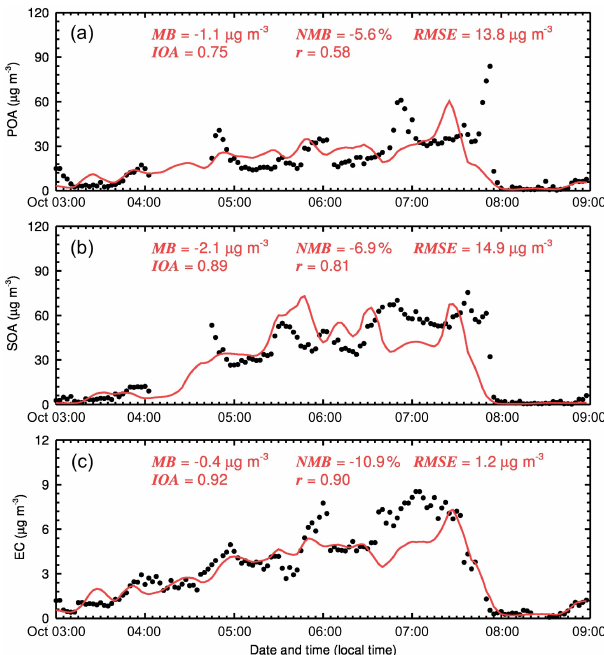
Figure 8. Diurnal variations in the modeled (red curves) and ob- served (black dots) surface (a) PM 2 . 5 , (b) O 3 , and (c) NO 2 concen- trations averaged over 12 ambient monitoring stations in Beijing from 3 to 8 October 2015.